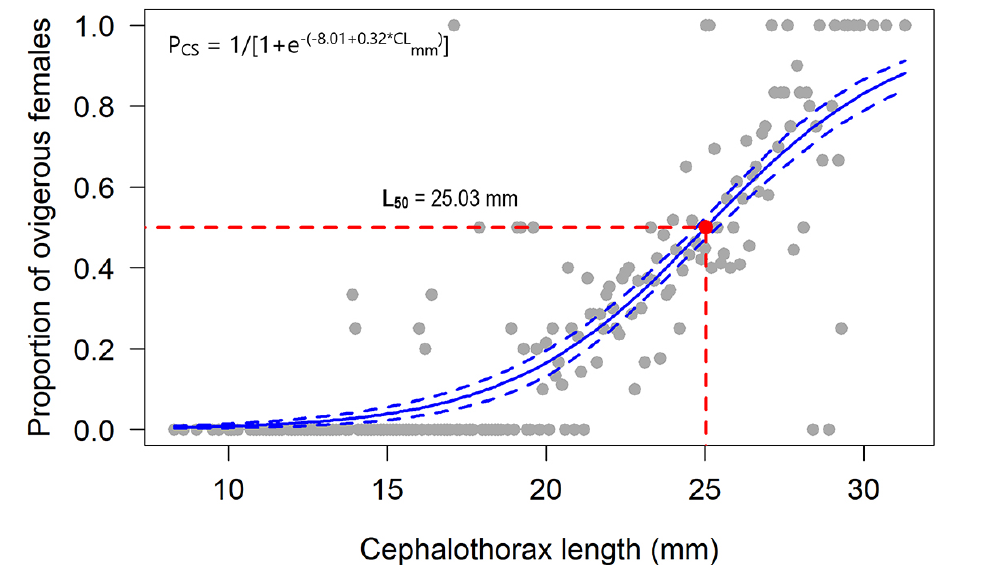
) estimated for Plesionika edwardsii in the Azorean region fitting a logistic Figure 7. Size at which 50 % of the shrimps are mature (L 50 curve to the proportion of ovigerous females. Logistic curve was estimated combining all data obtained during the period